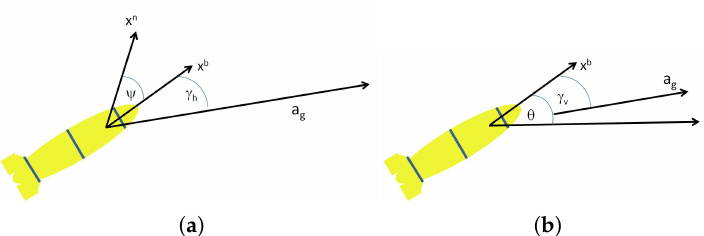
Figure 1. Illustration of the acceleration triangle experienced by a subsea device. The force induced by the water current over the drifter is translated into a shift in the heading direction, thus creating an horizontal and/or vertical directional angles between the drifter’s moving direction and its body frame. ( a ) Horizontal plane; ( b ) vertical